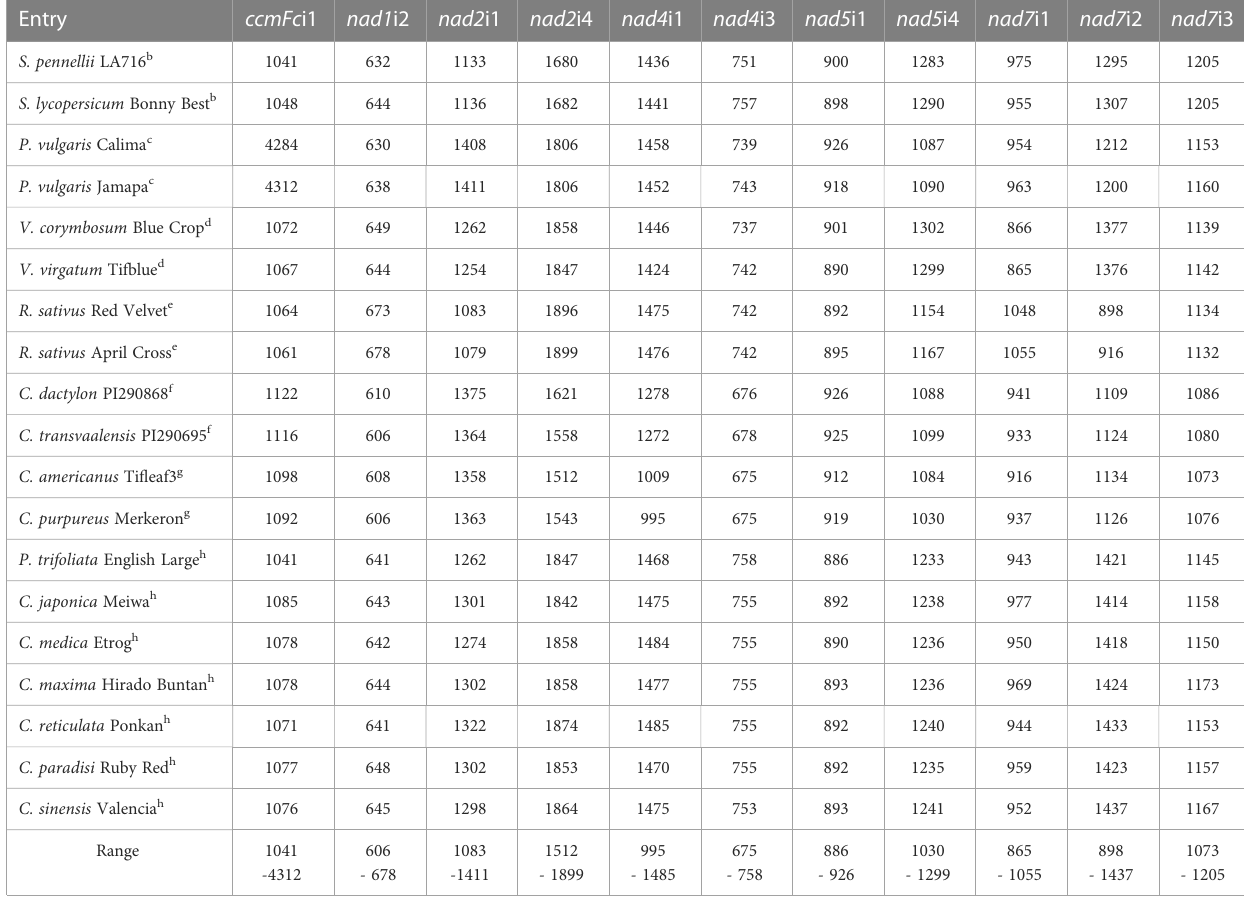
TABLE 3 Intron PCR product length a estimated by Advance ™ capillary electrophoresis.